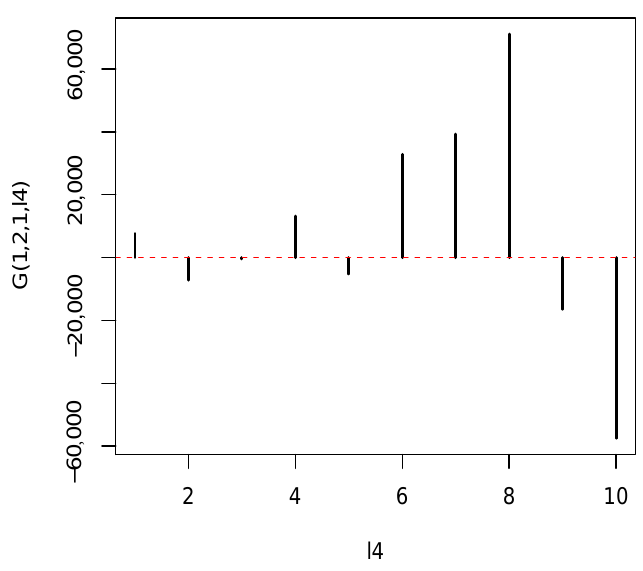
Figure 6. G ( 1,2,1, (cid:96) 4 ) when HOSVD is applied to the real